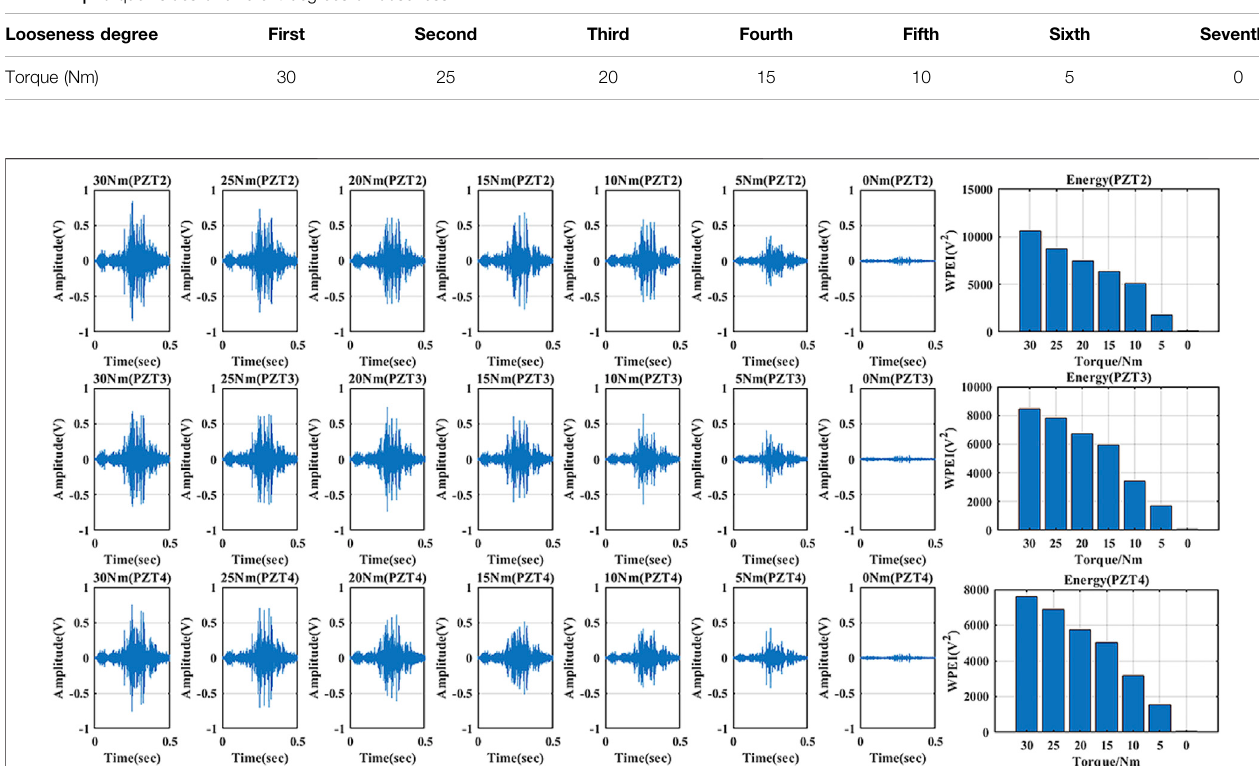
FIGURE 10 | Stress wave signals and wavelet energy received in the three channels under different torque levels.